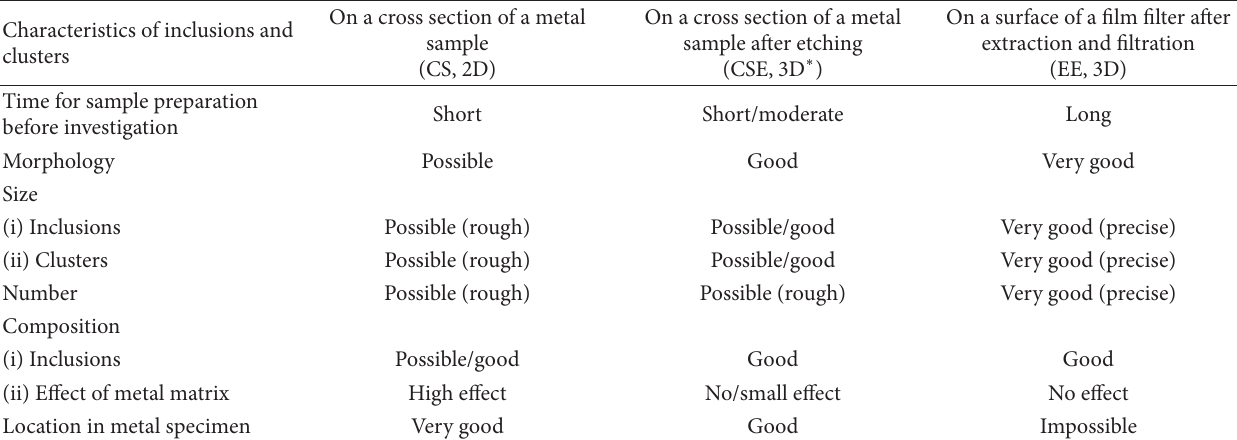
Table 3: Application of three methods for 2D and 3D investigations of nonmetallic inclusion particles and clusters in metal sample. On a cross section of a metal Characteristics of inclusions and clusters Time for sample preparation Short Short/moderate before investigation Morphology